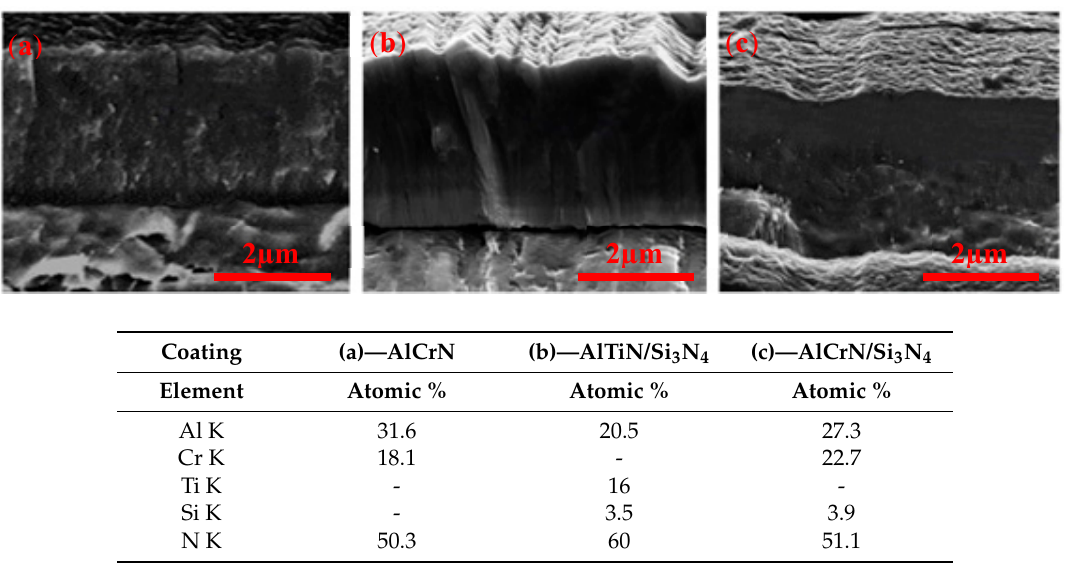
Figure 3. Scanning electron microscopy (SEM) images of coatings cross-section and glow discharge optical emission spectroscopy (GDOES) results for coating chemical composition, ( a ) AlCrN PVD Coating; ( b ) AlTiN/Si 3 N 4 PVD nanocomposite; and ( c ) AlCrN/Si 3 N 4 PVD nanocomposite coating.